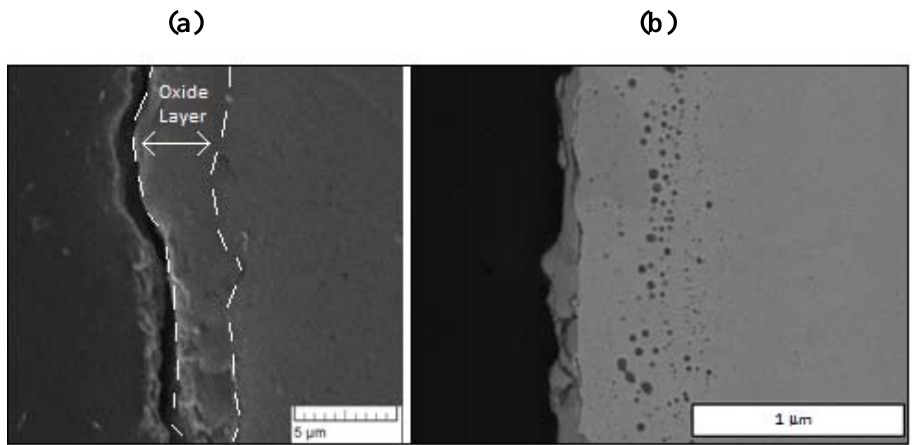
Figure 3. Scanning electron microscope (SEM) images of oxide samples terminated after oxidation: ( a ) After 24 cycles at a reactor temperature of 685 K; and ( b ) after 21 cycles at 765